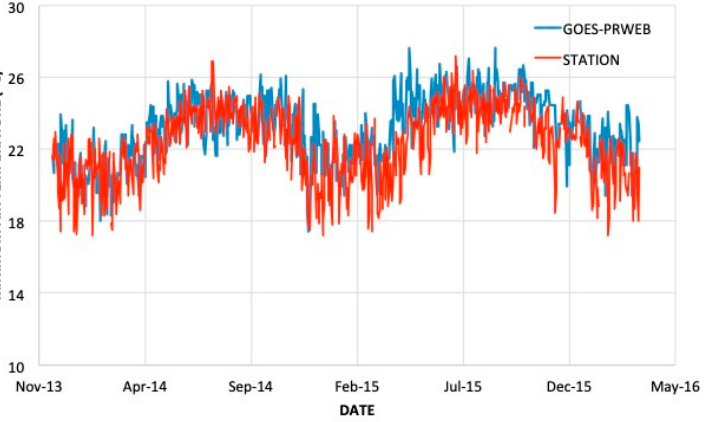
Figure A1. Modeled and observed T min from January 2014 to April 2016 at the UPR Agricultural Experimental Station near Juan Diaz, Puerto Rico.